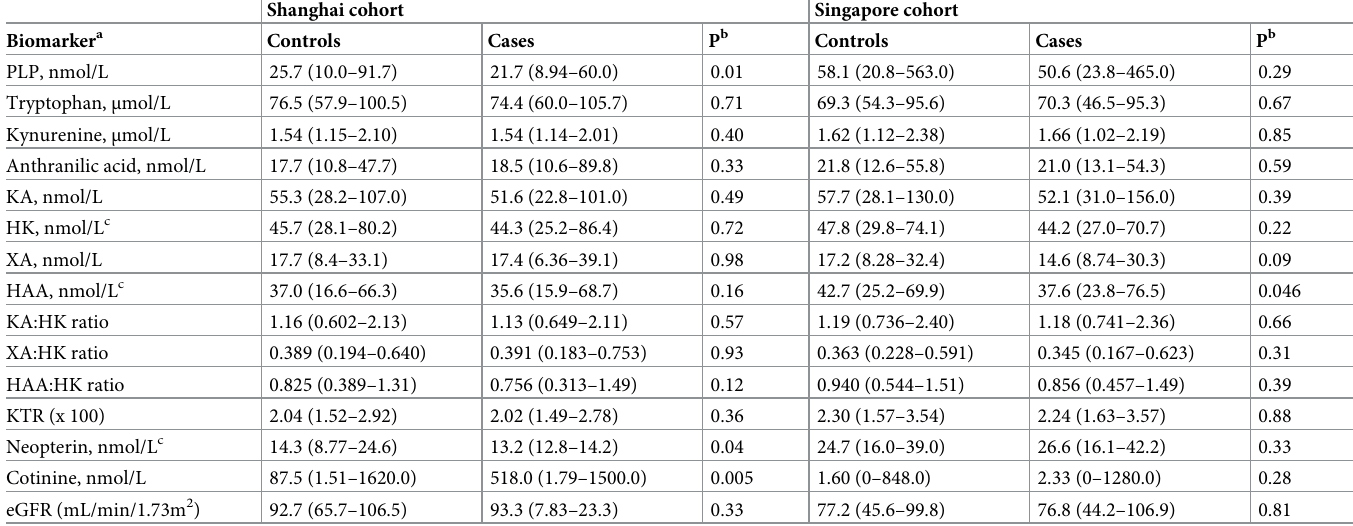
Table 2. Median (5 th – 95 th percentile) values of serum biomarkers of tryptophan, kynurenines and neopterin in pancreatic cancer cases and control subjects, the Shanghai Cohort Study and the Singapore Chinese Health